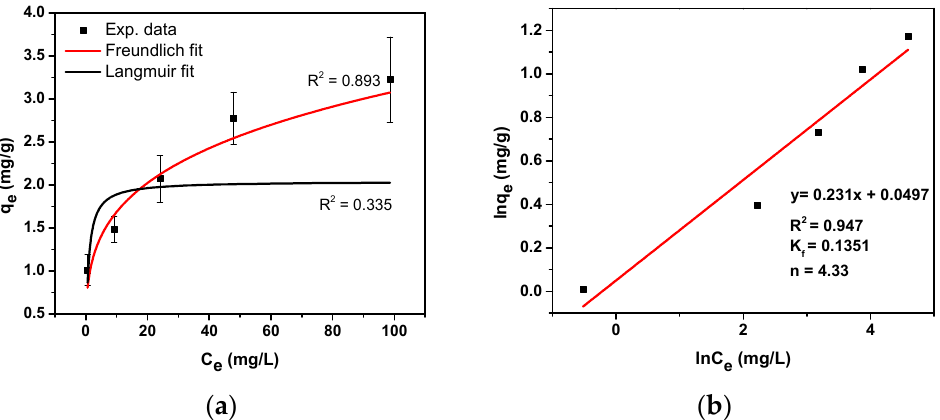
Figure 9. Adsorption isotherm of SMX using TMPES and P4VP-PEO-modified CNFs films fitted with the non-linear forms of the Freundlich and Langmuir models ( a ) and the linear form of the Freundlich model ( b ).